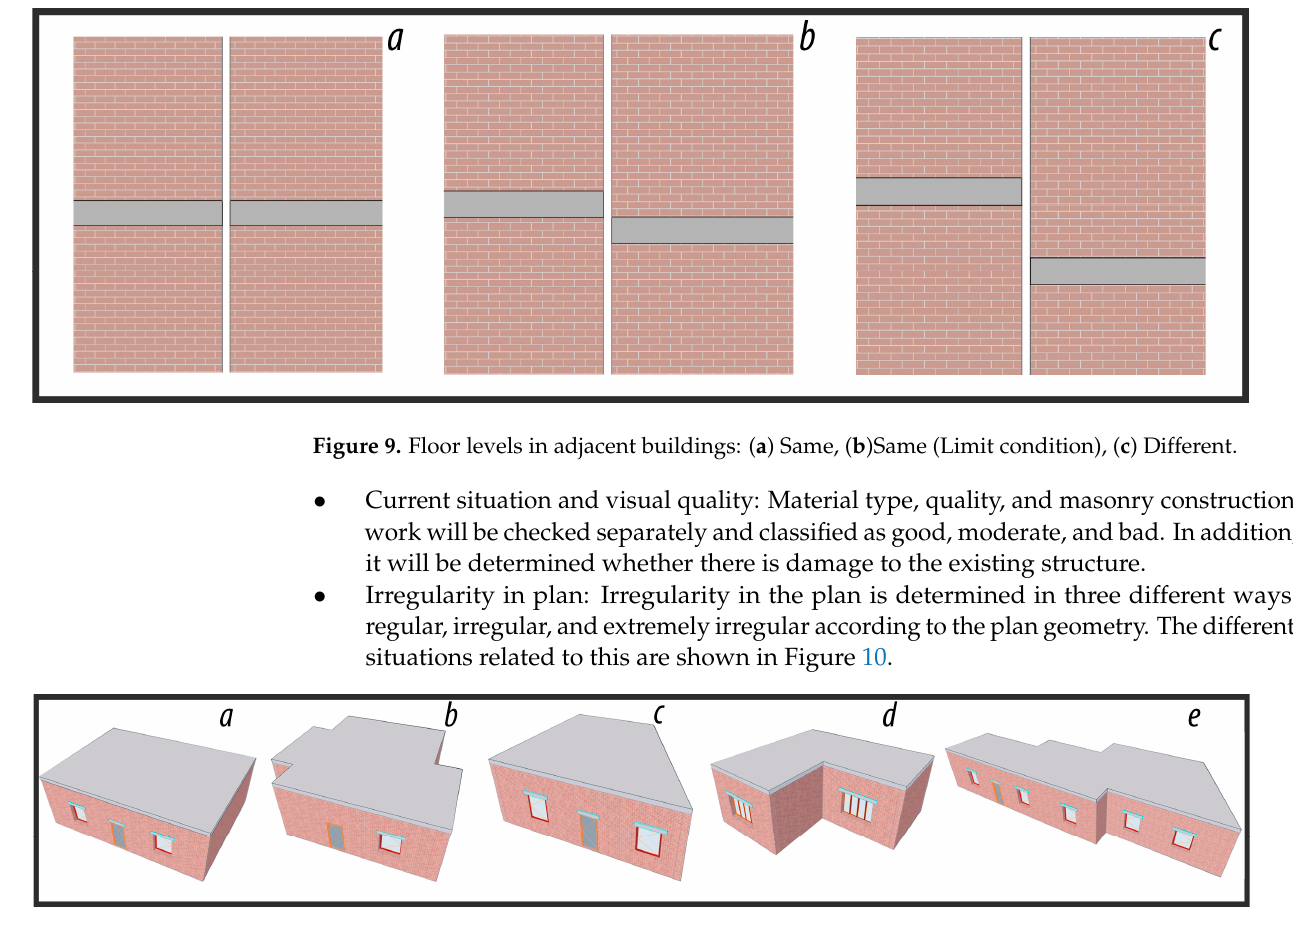
Figure 8. Structure order: ( a ) Separate, ( b ) Adjacent middle, ( c ) Adjacent edge, ( d ) Adjacent corner. If the investigated building is adjacent, floor levels should also be taken into account in these buildings (Figure 9).